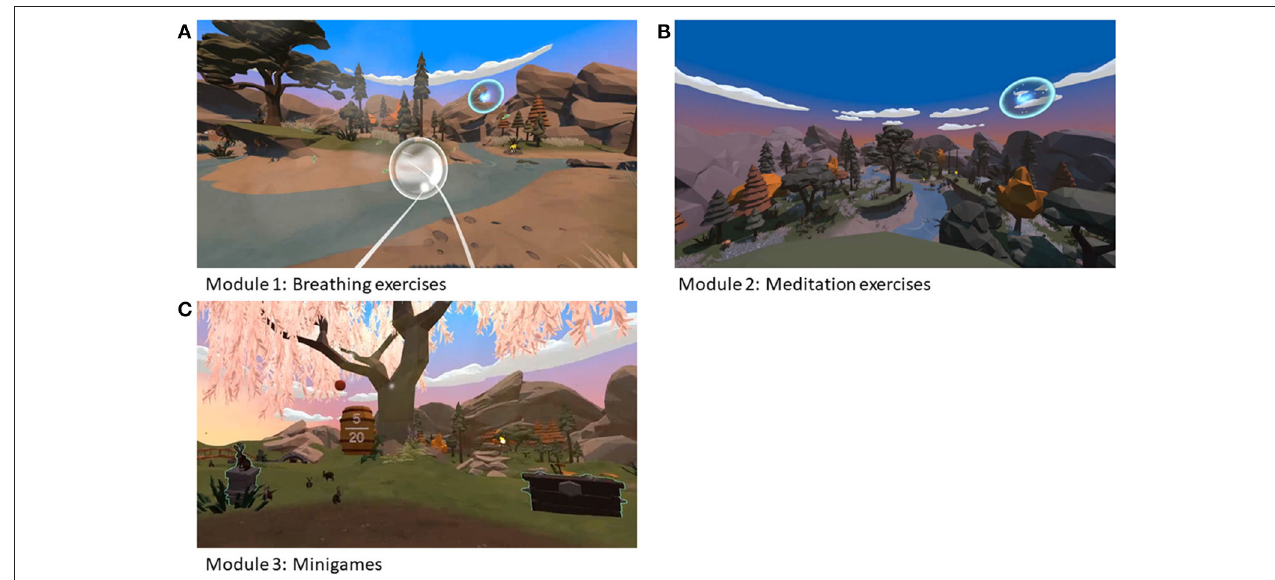
FIGURE 2 | Images of Relaxation-VR modules 1 (A) , 2 (B) , and 3 (C)